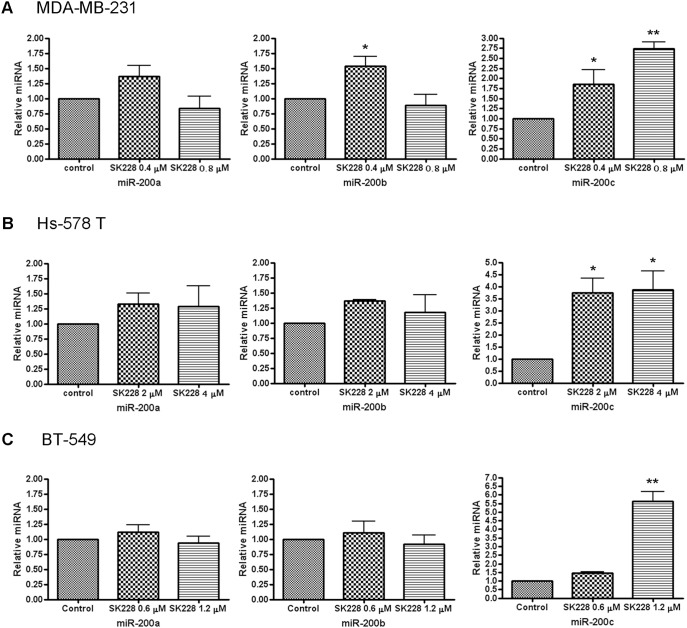
miRNA real-time PCR shows that SK228 induces the exoression of miR-200 family in breast cancer cells.Cells are treated with different concentrations of SK228 for 48-200 family are analyzed by using real-time PCR. (A) MDA-MB-231 cells, (B) Hs-578 T cells, (C) BT-549 cells.